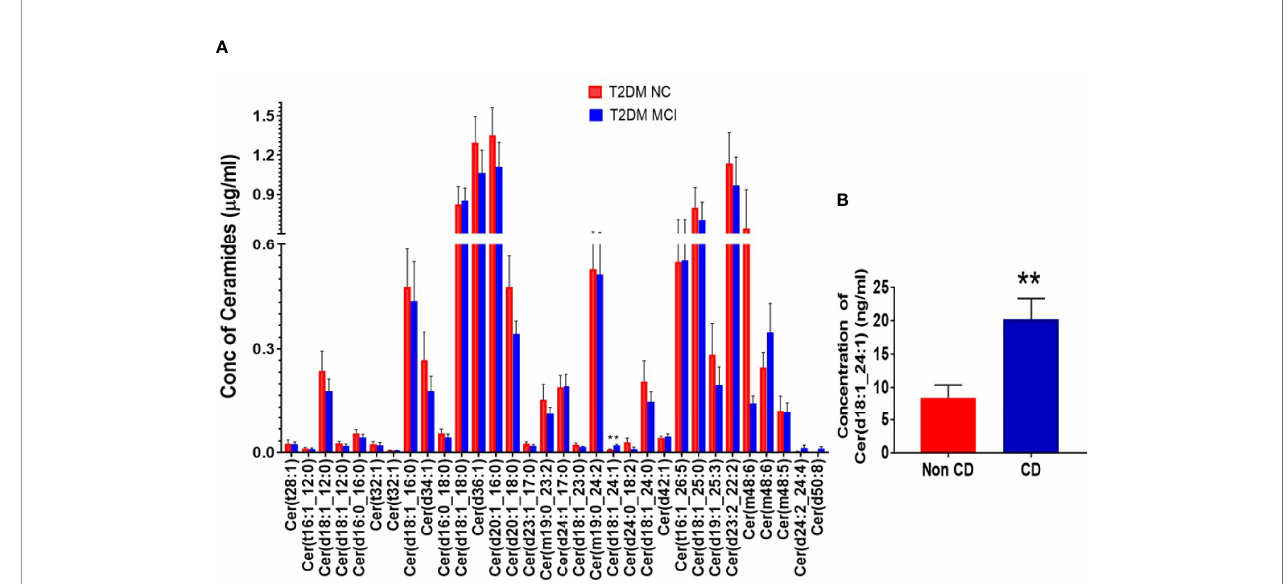
FIGURE 3 | A detailed evaluation of the concentrations of 32 ceramide species individually in the serum type 2 diabetes mellitus patients with mild cognitive impairment (MCI) versus normal cognition (NC). Individual species comparisons were given in (A) . This comparison identi fi ed signi fi cantly higher levels of